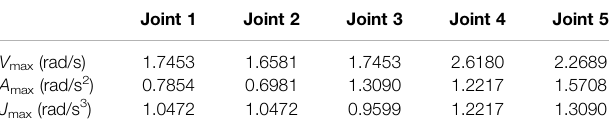
TABLE 4 | Constraint conditions of each joint.